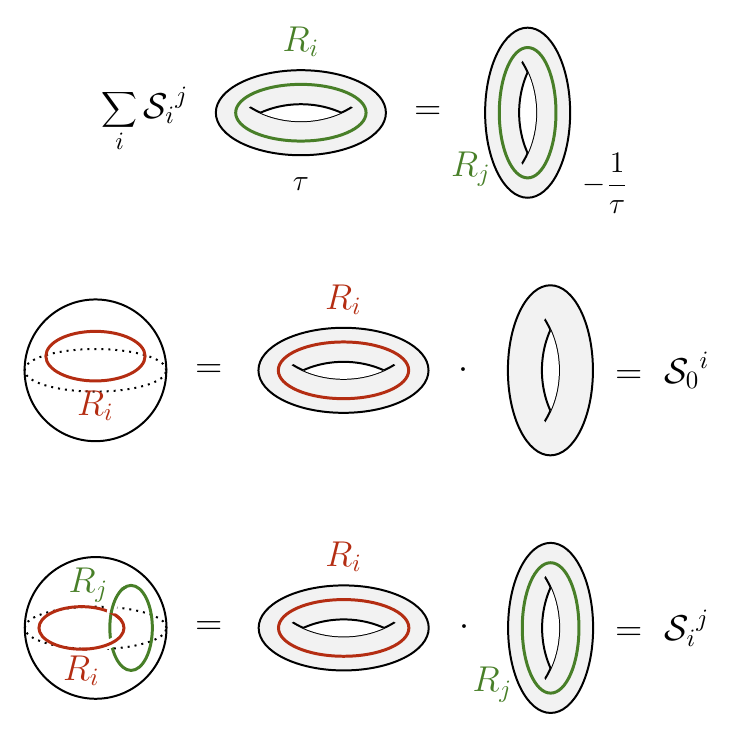
Figure 2 . The modular transformation in Chern-Simons gauge theory and the evaluations of the partition functions with Wilson loops. The horizontal solid tori have a complex structure τ while the vertical ones have − 1 /τ . The dot means the gluing along the torus on the boundaries of two solid tori.